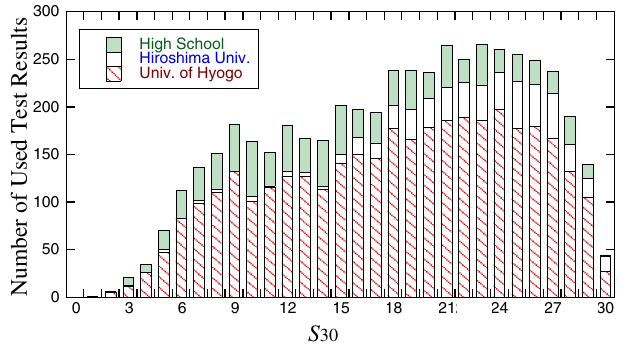
FIG. 1. Distribution of the FCI